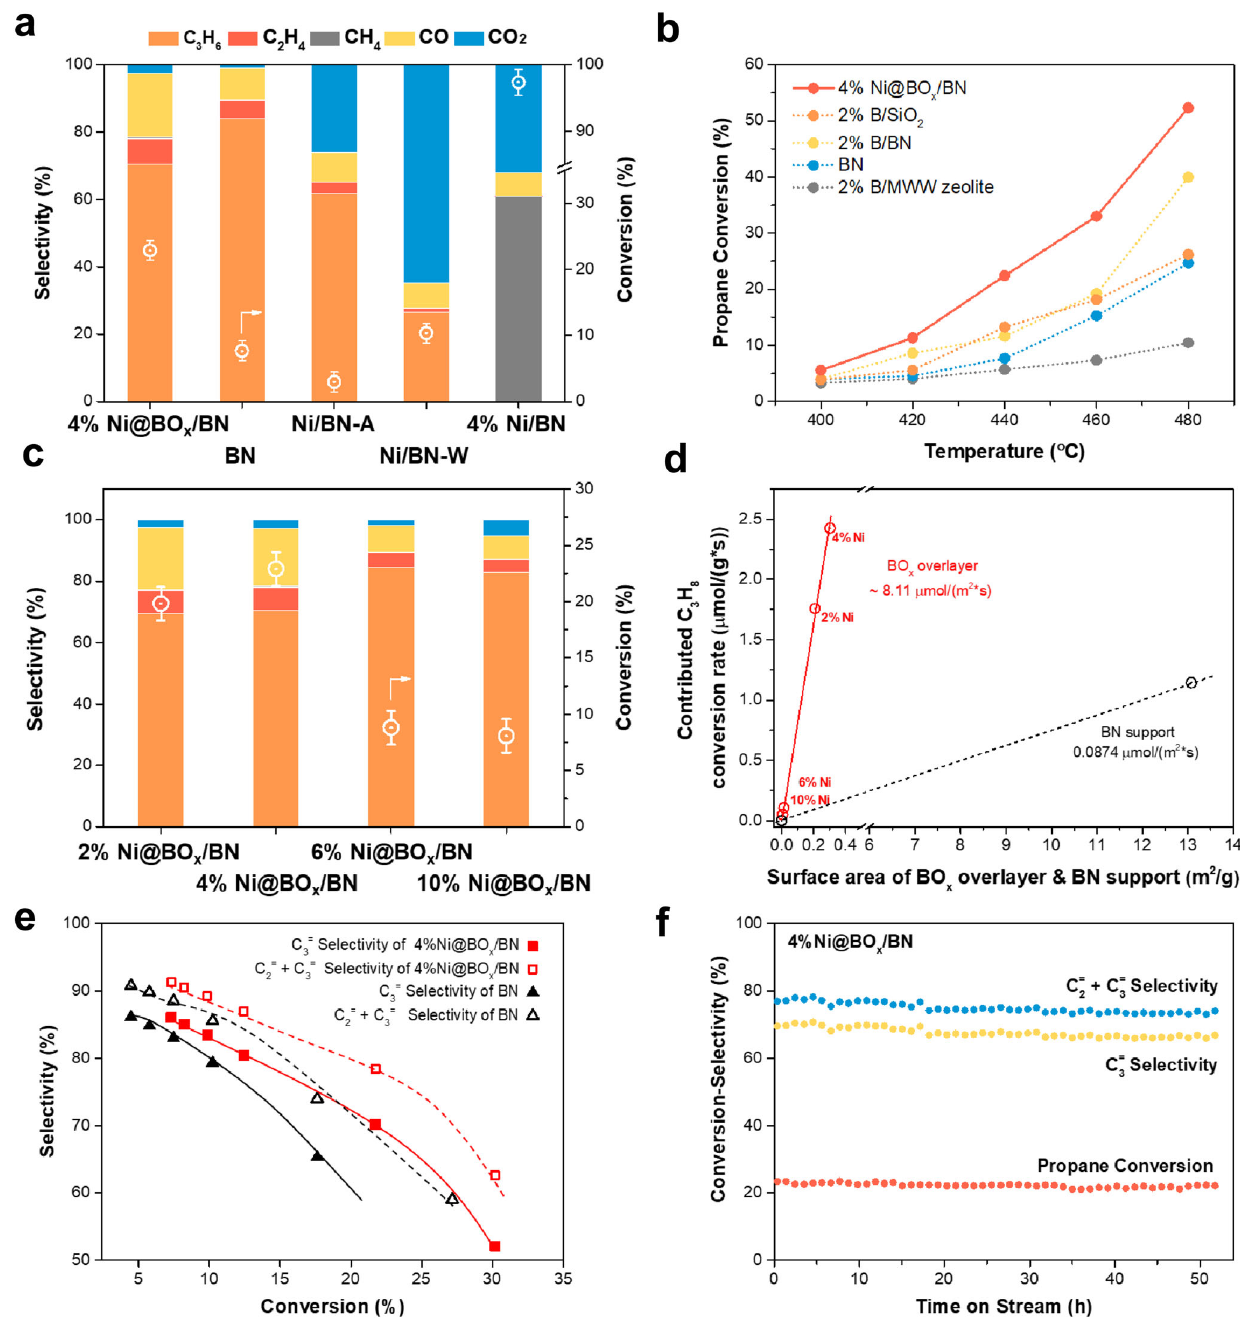
Fig. 2 | Catalytic performance of Ni@BO x /BN catalysts in the oxidative dehy- drogenation reaction of propane (ODHP). a Comparison of the activity and selectivityoftheNi@BO x /BNcatalystwithh-BNandotherNi-BNcompositesforthe ODHP reaction. b Temperature-dependent performance of Ni@BO x /BN and other nonmetalboron-basedODHPcatalysts. c ThecatalyticperformanceofNi@BO x /BN